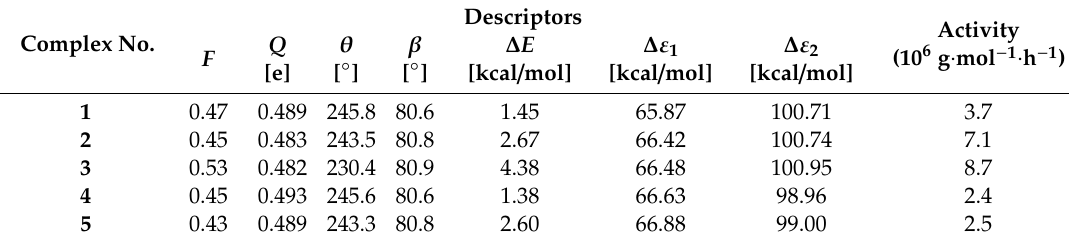
Table3. ThevaluesofHammettconstant( F ),e ff ectivenetcharge( Q e ff ), openconeangle( θ ), biteangle( β ), energy di ff erence ( ∆ E ) and HOMO–LUMO energy gap ( ∆ ε 1, ∆ ε 2 ) together with experimental catalytic activities for complexes 1 – 5